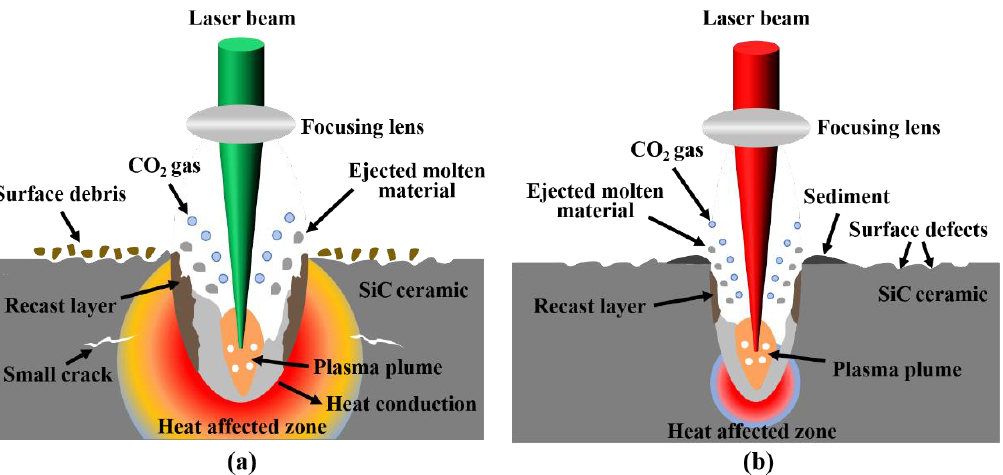
Figure 3. ( a ) The schematic diagram of nanosecond laser ablation of SiC ceramics and ( b ) the schematic diagram of femtosecond laser ablation of SiC ceramics.